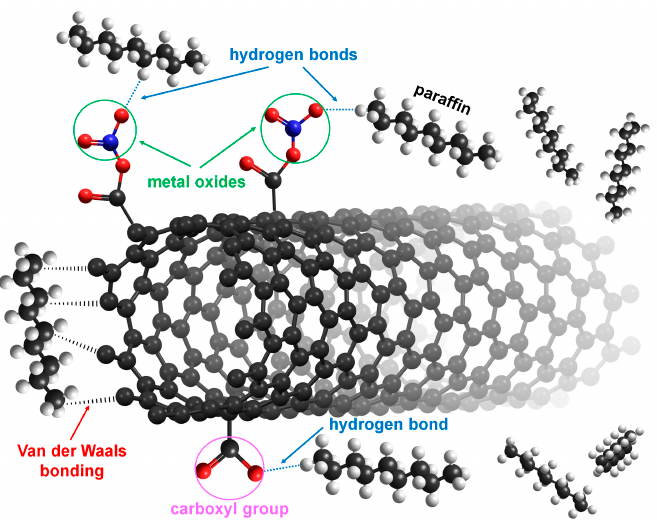
Figure 13. Schematic interaction/adsorption of the alkane molecules on the surface of MWCNTs samples.